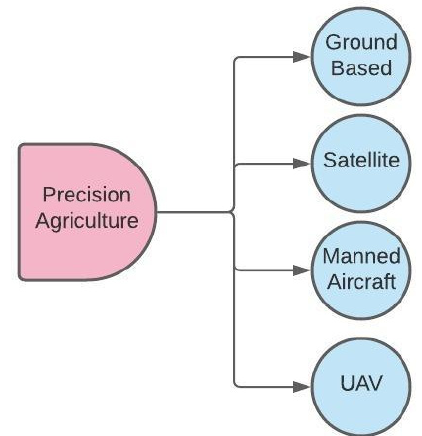
Figure 1. RS Platforms in precision agriculture. UAV is flexible for most applications and addresses the solutions for the problems faced by other RS platforms